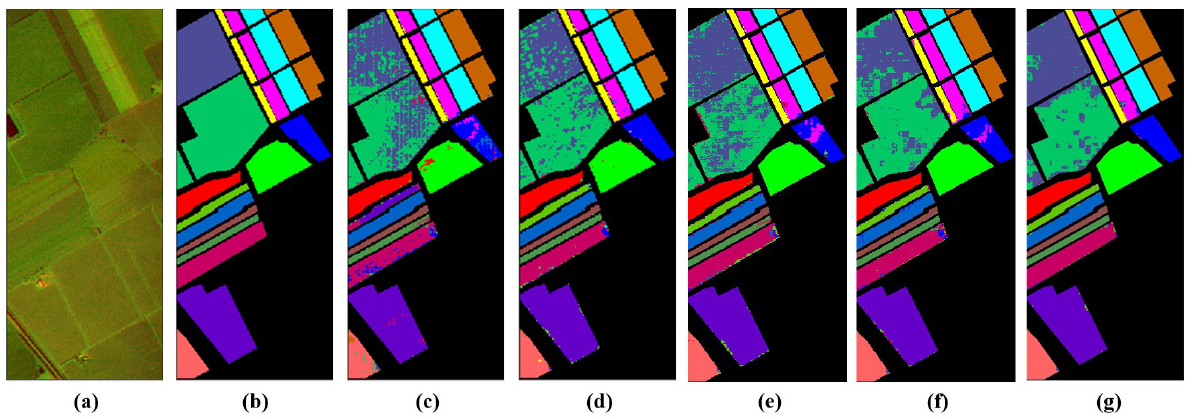
Figure 8. Classification maps of different models for Salinas Valley dataset: ( a ) false-color composite image; ( b ) ground truth; ( c ) SS3FCN; ( d ) TAP-Net; ( e ) DA-IMRN (sub-net1); ( f ) DA-IMRN (sub-net2); ( g ) DA-IMRN.